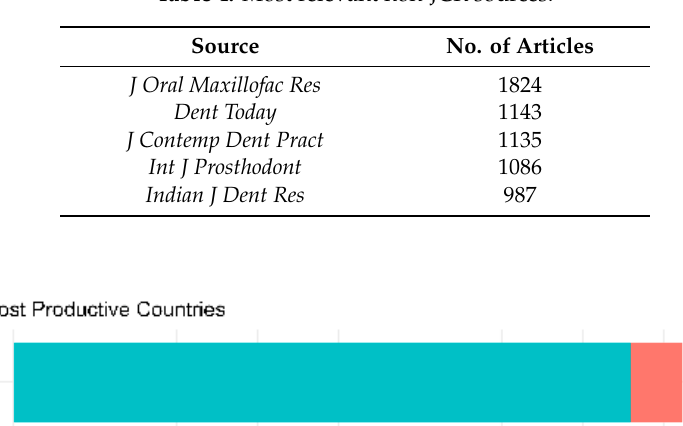
Table 4. Most relevant non-JCR